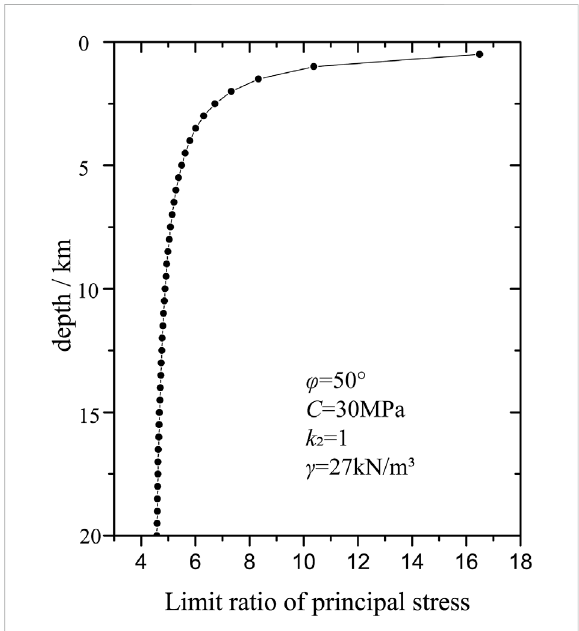
FIGURE 5 Relationship between limit and depth of principal stress ratio.